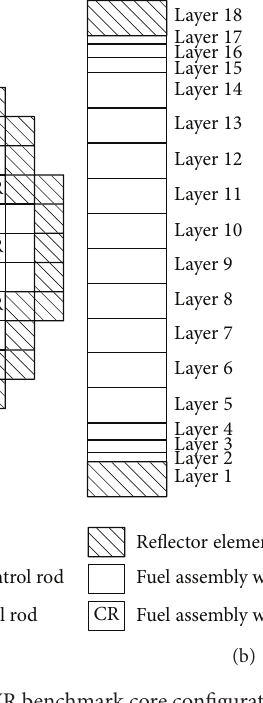
Figure 1: The radial (a) and axial (b) PWR benchmark core configuration [22]. Table 1: Operational data for the A1, A2, B1, and B2 benchmark